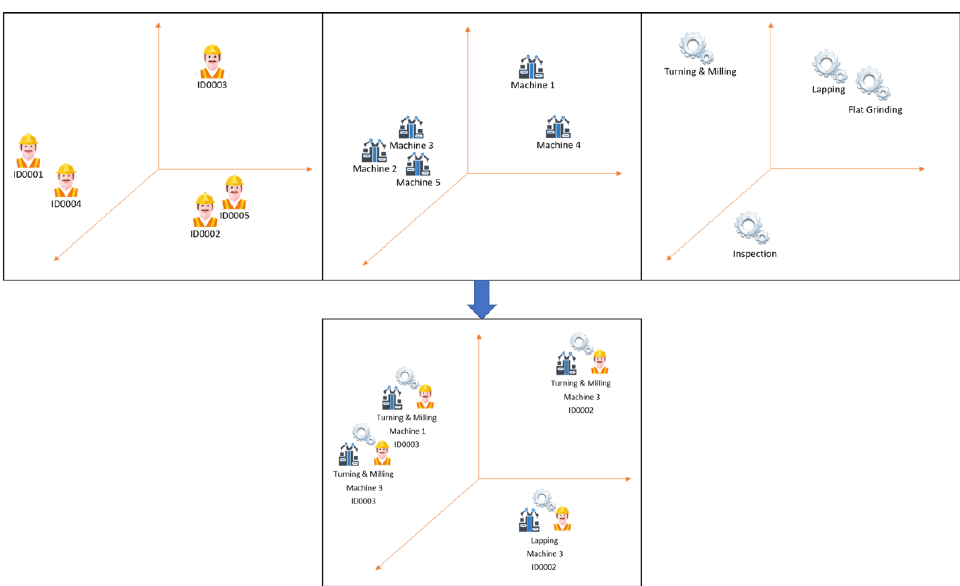
Figure 5. Illustration of comparison of vectors of entity embedding (top) with those of DAEE (bottom) in multi-dimensional space. Algorithm 1. DAEE Build-Up from SOP